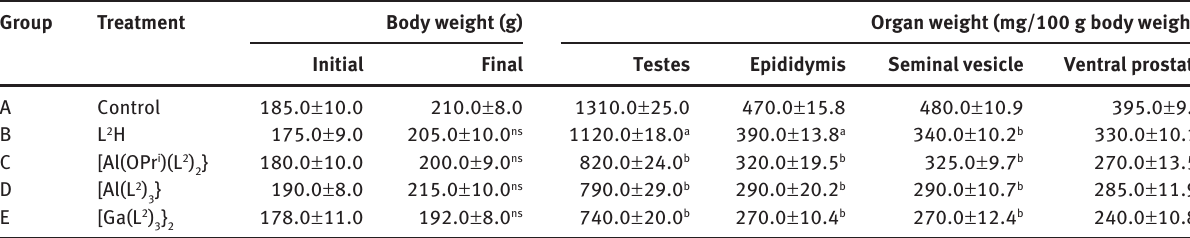
ns, nonsignificant, group B compared with group A. a Significant for groups C, D, E and F compared with group A, p < 0.01. b Highly significant, p < 0.001.